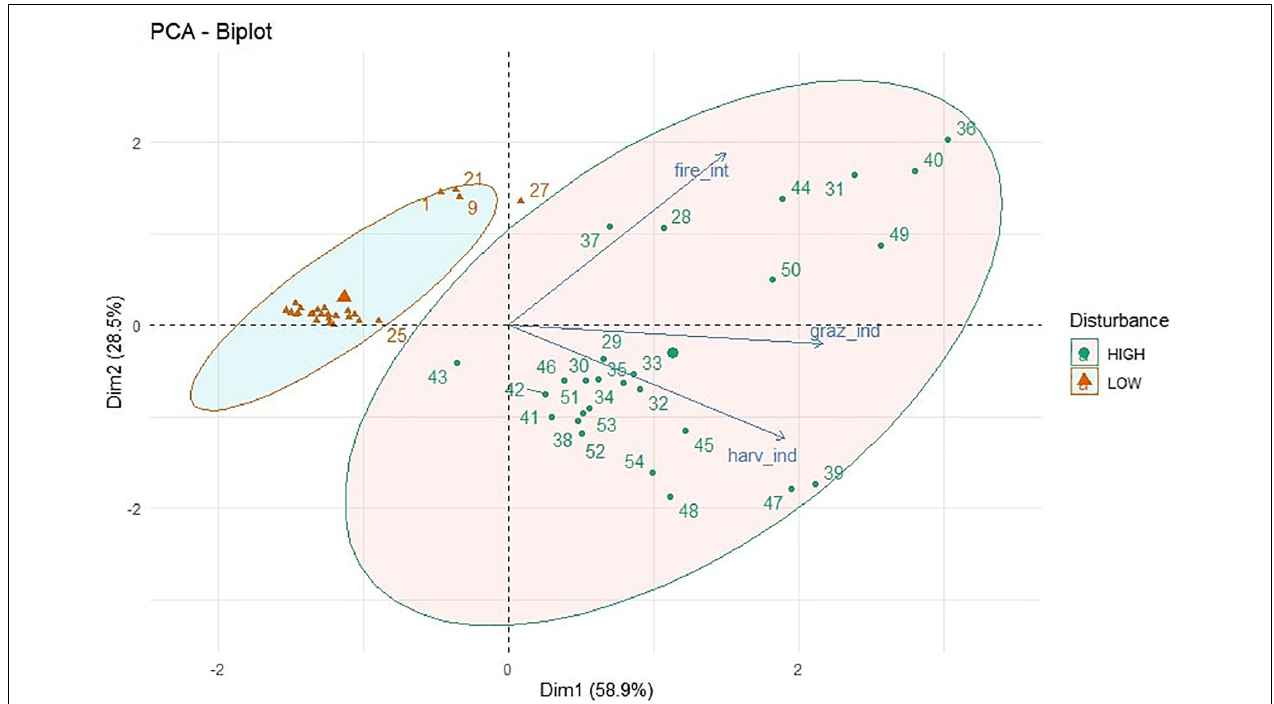
FIGURE 1 | PCA showing clusters of low and high disturbed study sites based on harvest index, grazing index, and fire intensity at those